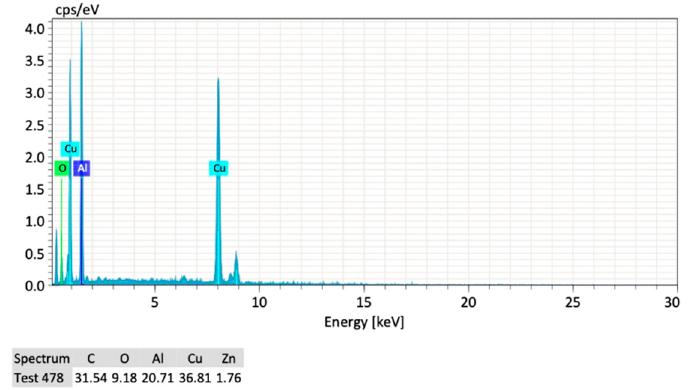
Figure 10. Typical EDX spectrum.